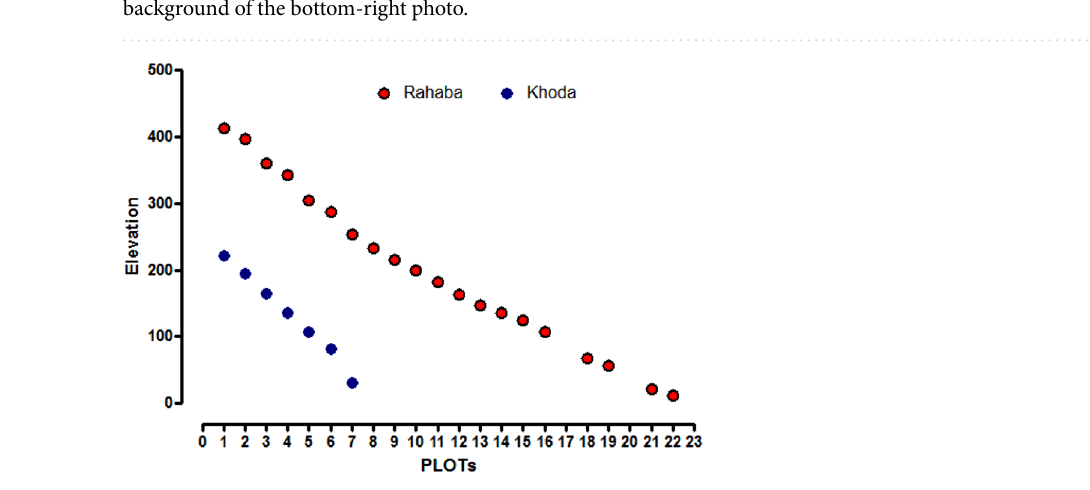
Figure 4. The elevation (m) of the macroplots in which Vachellia tree taxa were sampled. Red symbols indicate the elevation of the macroplots analyzed in wadi Rahaba and blue symbols indicate the elevation of the macroplots analyzed in wadi Khoda, Gebel Elba National Park, south-eastern